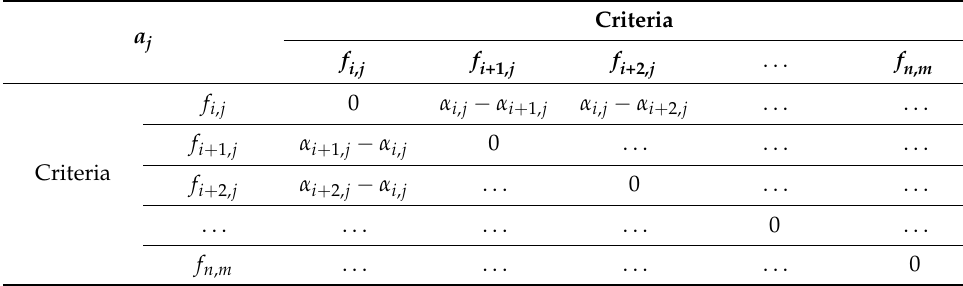
Table 2. Conversion matrix.